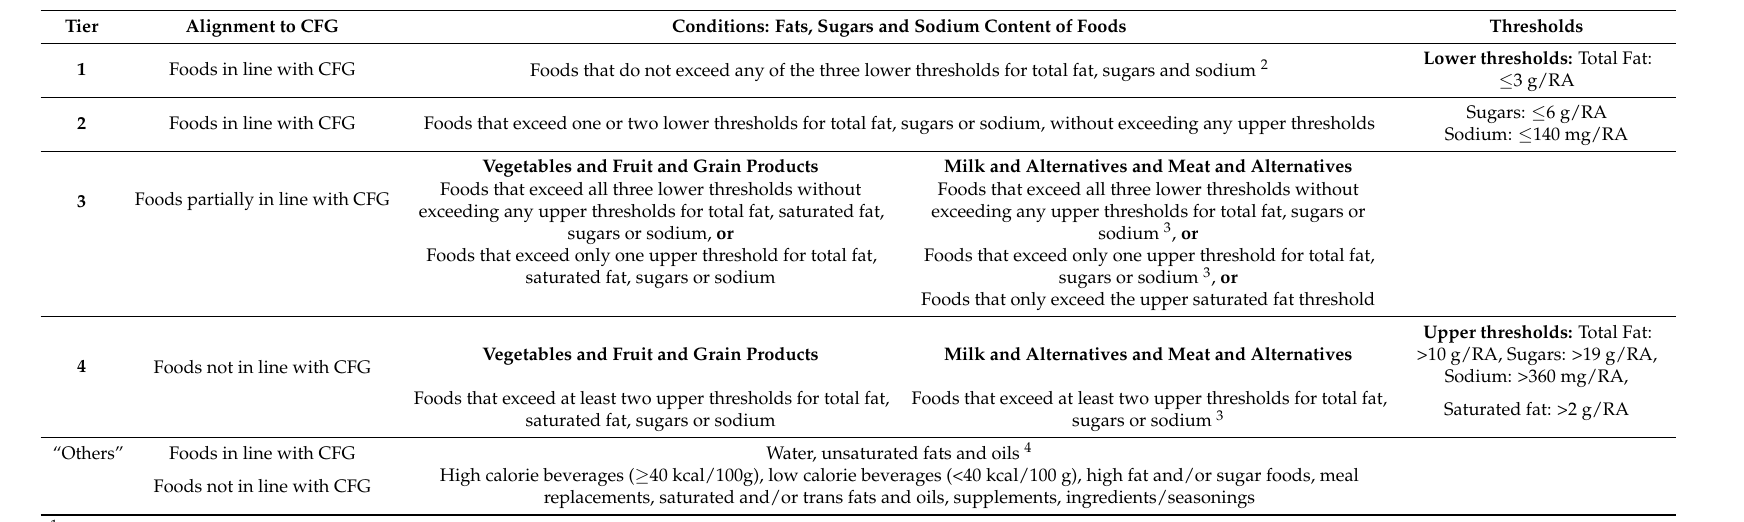
Table 1. Health Canada Surveillance Tool Tier Thresholds 1